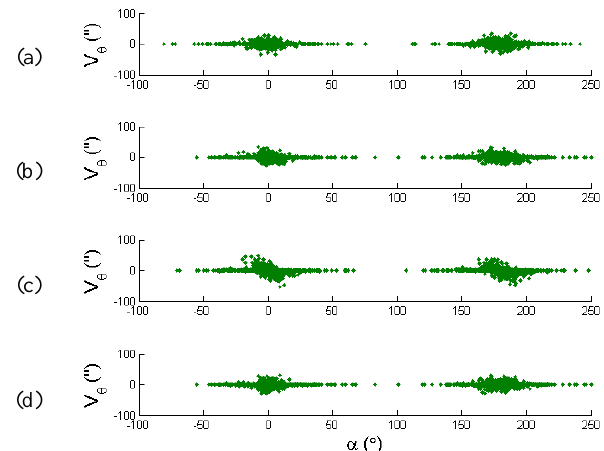
Figure 7: (a) Horizontal angle residuals versus vertical angle plot in plane-based self-calibration for panoramic scanners without systematic errors. (b) Unmodelled 1’ trunnion axis error. (c) Unmodelled 3’ trunnion axis error. (d) After plane- based